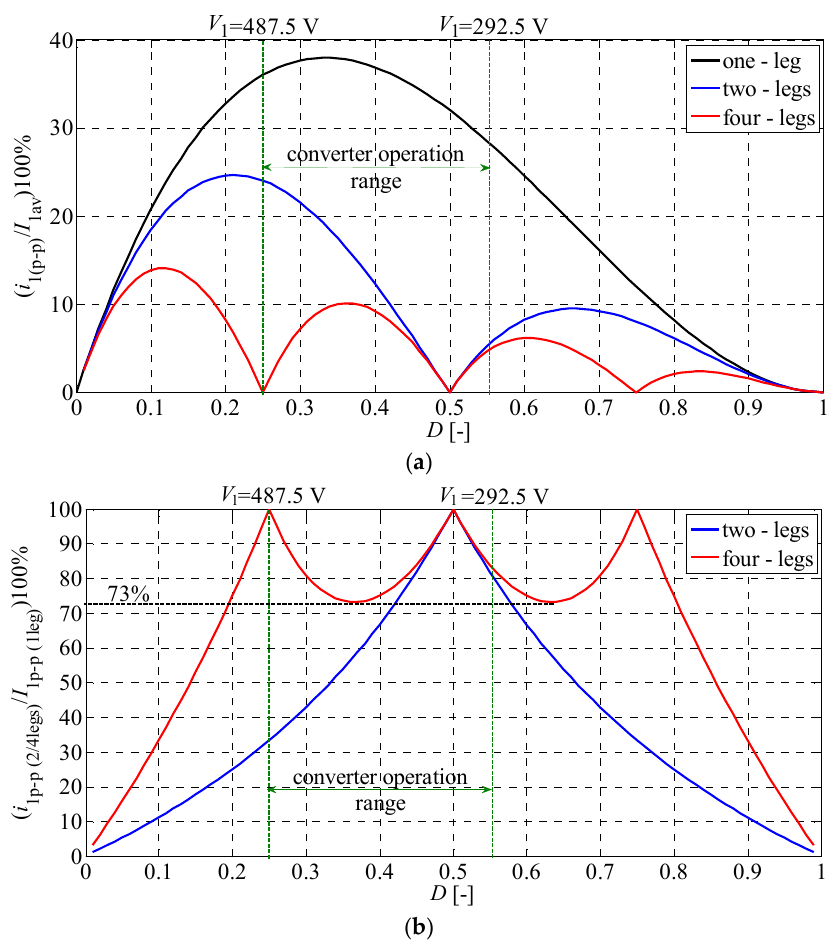
Figure 2. ( a ) Percentage of the input current ripples for the single-, two- and four-leg(s) configuration of converter and ( b ) percentage reduction of current ripples due to interleaving of converter legs relative to one-leg converter.